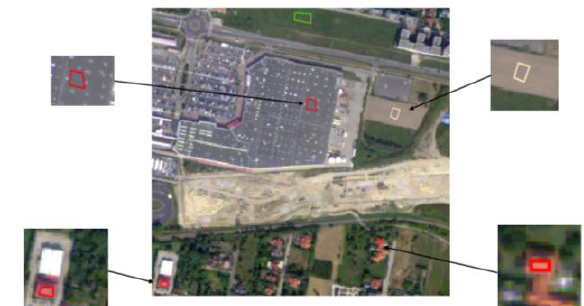
Figure 6. Training samples for image classification: buildings, roads, bare soils, vegetated area and water.